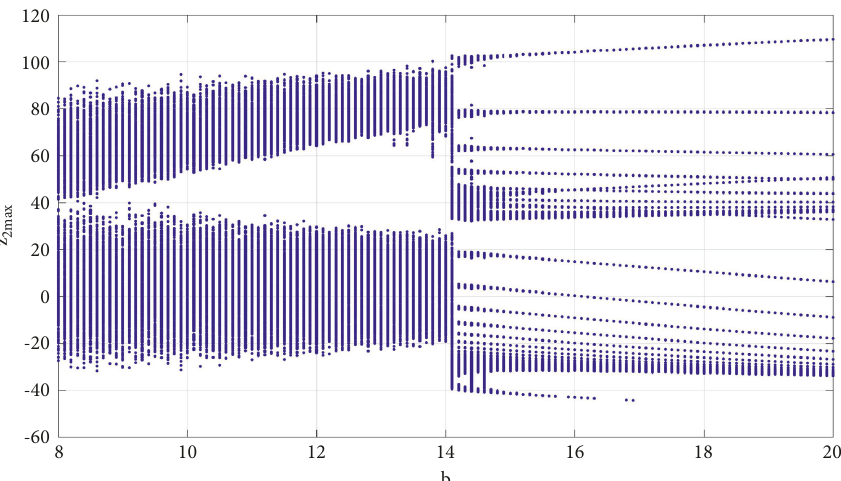
Figure 8: Bifurcation diagram for the model (1) when b varies in [ 8 , 20 ] and ( a,c, d ) � ( 25 , 90 , 6 )